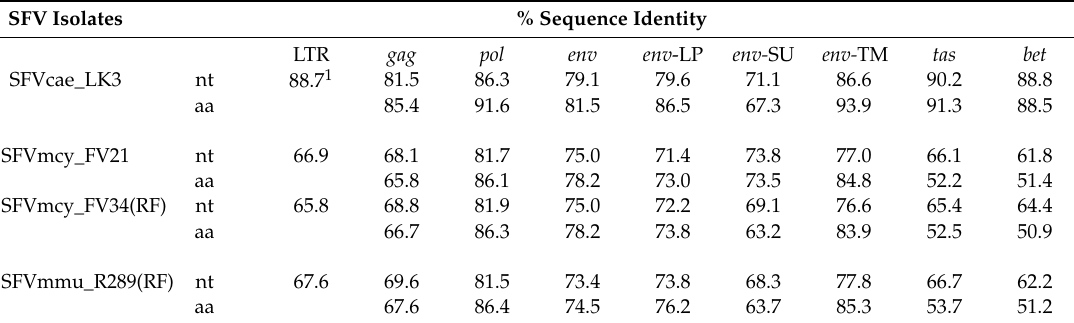
Table 4. Sequence comparison of SFVcae_FV2014 and di ff erent SFV isolates. SFV